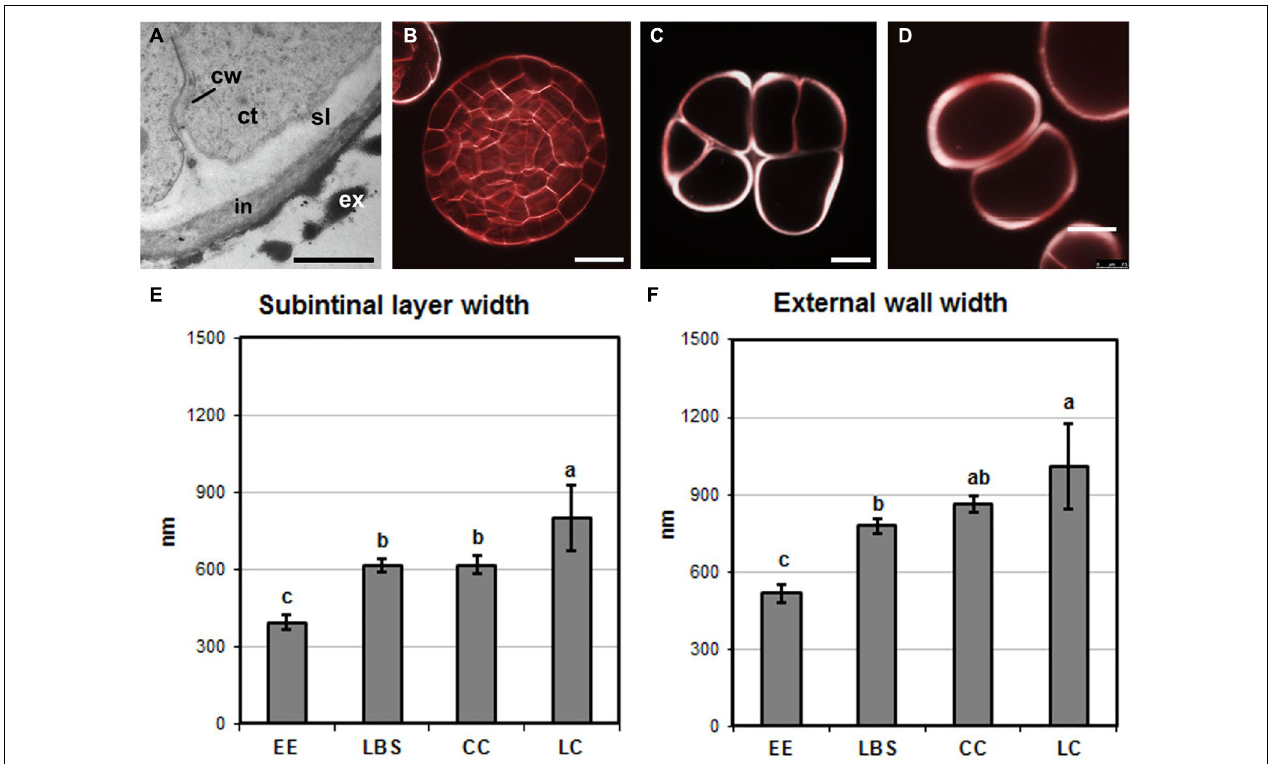
FIGURE 2 | Cell wall width. (A) Electron microscopy image of an exine-enclosed (EE) structure, showing the inner cell wall (cw), subintinal layer (sl), intine (in), and exine (ex). ct, cytoplasm. (B–D) Images of structures stained with SCRI Renaissance Cell 2200 observed by confocal microscopy. (B) Young, EE-derived embryo, (C) compact callus (CC), and (D) loose callus (LC). (E) Subintinal layer width (in nm) in each type of structure. (F) Width (in nm) of the intine + subintinal layer in each type of structure. Different letters represent significant differences according to the LSD test. Bars: (A) , 500 nm; (B–D) , 10 µ m.